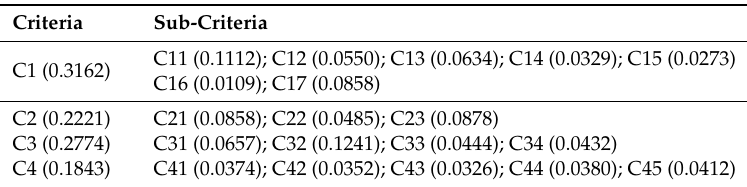
Table 6. The corresponding weights of criteria and sub-criteria.